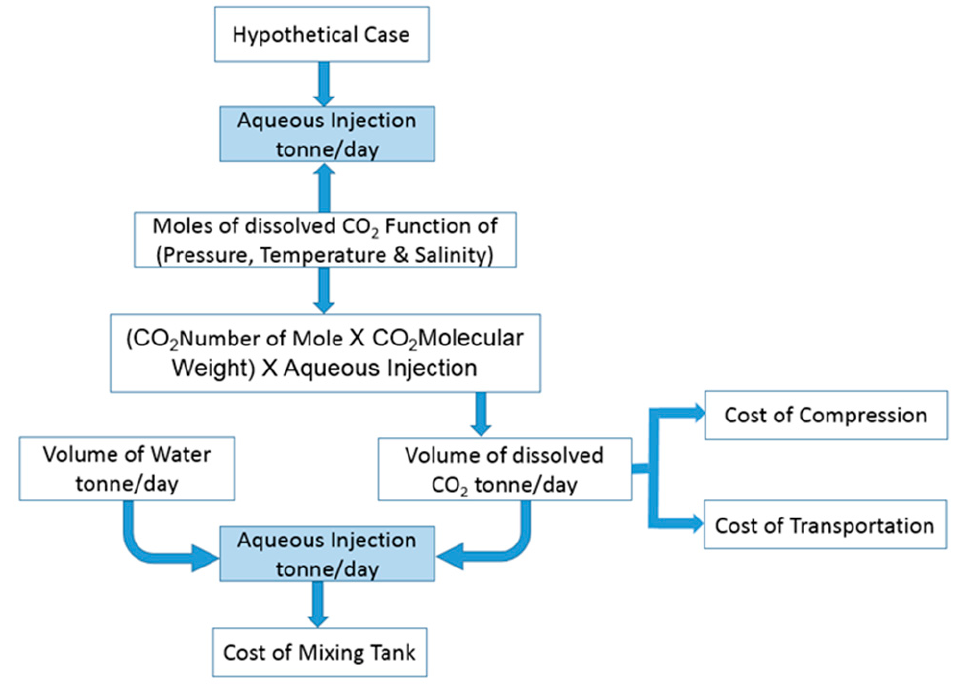
Figure 1. Illustrative scheme of cost calculation elements of CO 2 , brine and aqueous injection.